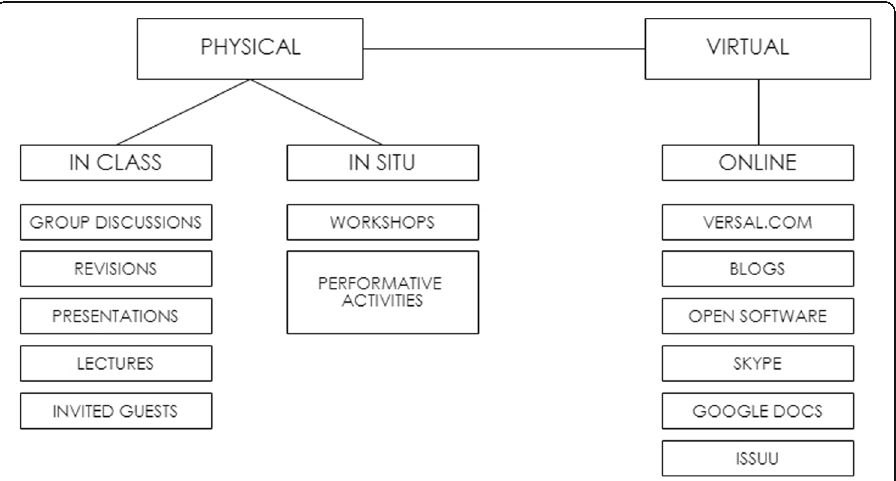
Fig. 1 Course blending: learning environments and their respective